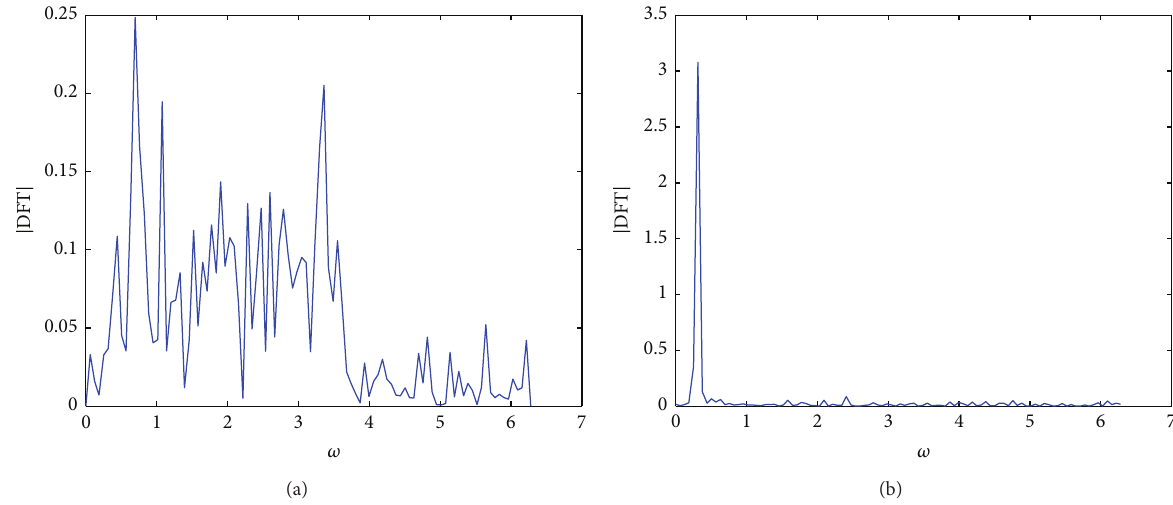
Figure 5: Plot of the absolute value of DFT for the filtered signal in Model 1 with 𝑁 = 100 and 𝜎 2 = 1.5 where the two figures correspond to the signal filtered by the initial estimator (a) and proposed estimator (b) of 𝜔 2 , respectively.